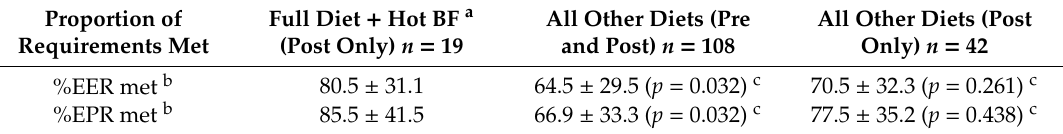
Table 3. Proportion of energy and protein requirements met in terms of diet